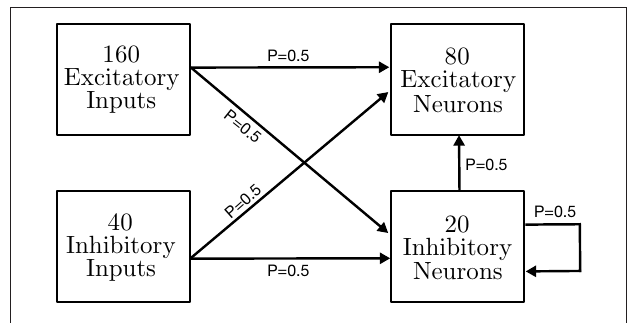
FIGURE 3 | Connectivity schematic of the implemented network. An excitatory and an inhibitory population of Poisson spike train generators stimulate an excitatory and an inhibitory population of neurons. The inhibitory population is fed back into itself and into the excitatory one. All inter-population projections have a unit-to-unit connection probability of 0.5.